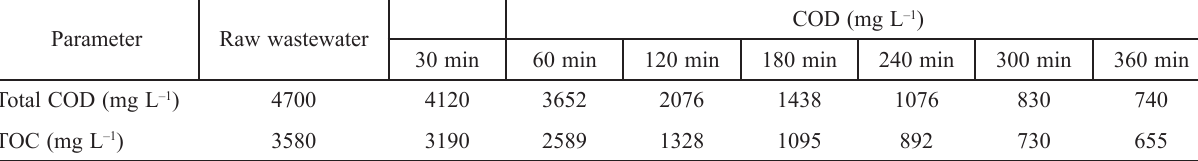
Table 6 – coD and Toc removal of raw textile wastewater using Mn, Mo, la/Tio